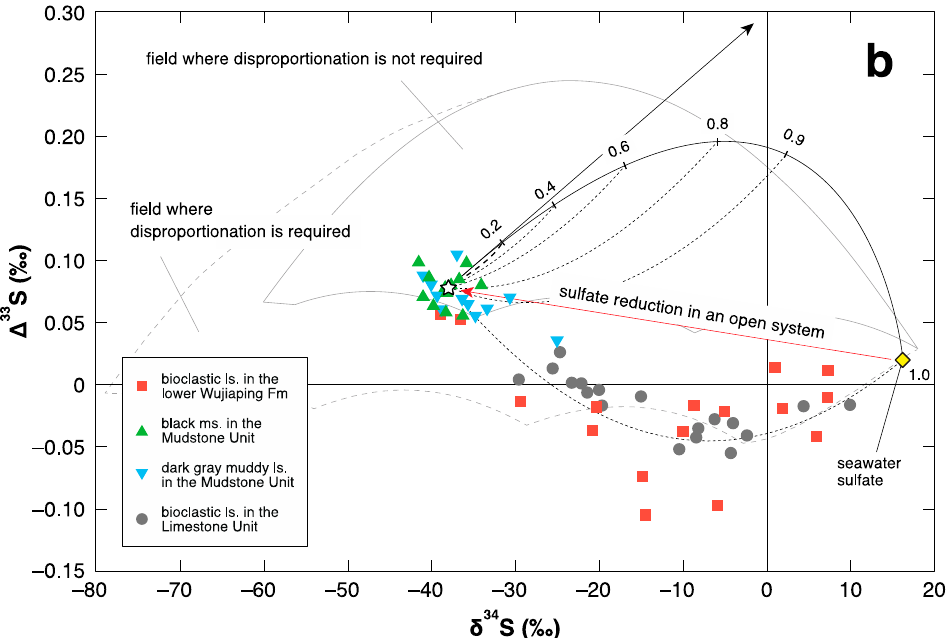
Figure 7. Multiple sulfur isotope record across the G-LB at Chaotian [100]. ( a ) sulfur isotope chemostratigraphy. A red line represents the estimated extinction horizon. M. Unit: Mudstone Unit, sil.: siliceous, calc.: calcareous, ms.: mudstone, ls.: limestone; ( b ) δ 34 S– ∆ 33 S cross plot. A star represents the average black mudstone. The solid black arrow and curve represent the evolution of instantaneously produced H 2 S and accumulatively produced H 2 S, respectively, via reduction of the contemporaneous seawater sulfate [68] in a closed system, assuming that the 34 ε and 33 λ values in MSR were 53.5‰ and 0.514 (red arrow), respectively. A number on the curve is a fraction of sulfate converted to H 2 S. A black dashed curve shows a mixing of accumulative H 2 S and sulfide produced in an open system (star). Note that the oxic limestones record the negative ∆ 33 S signals and are generally along the mixing curve between sulfide produced in an open system and sulfide produced via quantitative MSR in a closed system. Fields where disproportionation is required and not required are from Zhang G.J. et al. [69].